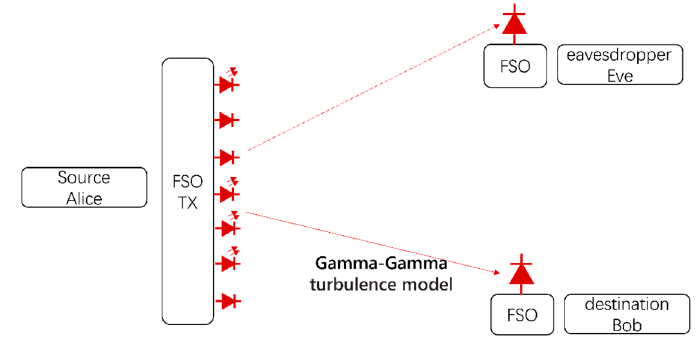
Figure 1. System model of SSK-VLC channel.